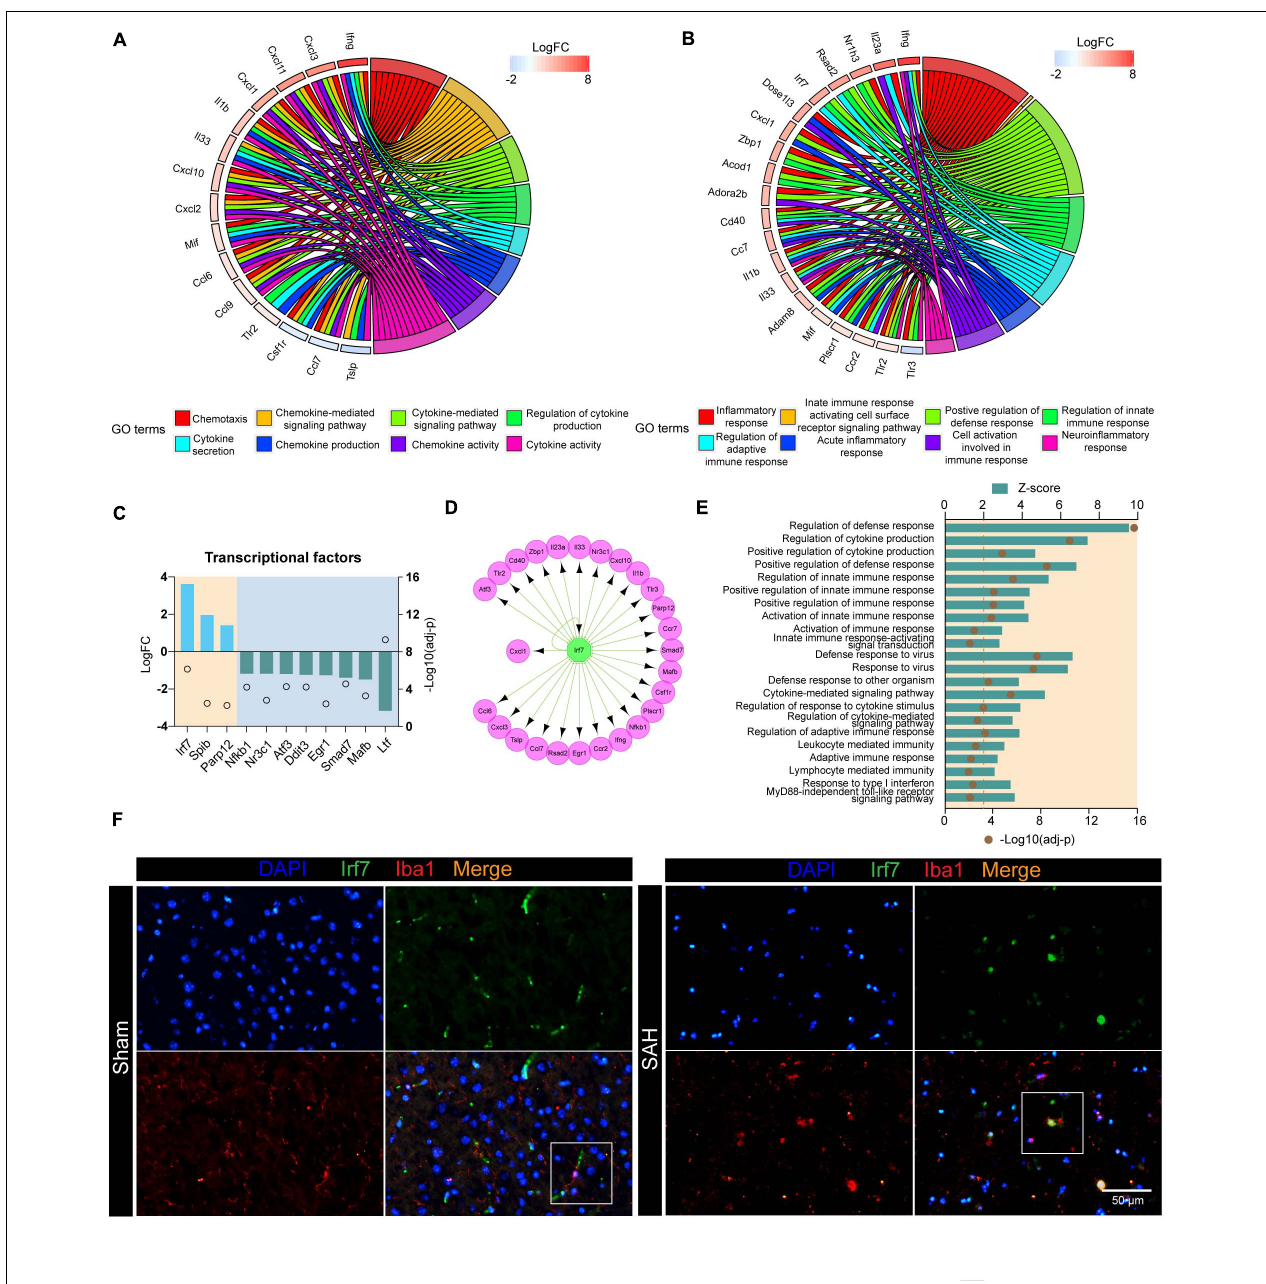
FIGURE 4 | Irf7 is a transcription factor involved in the post-SAH microglia. (A) Circular plot showed the DEGs involved in cytokine- and chemokine-related pathways. (B) Circular plot showed the DEGs involved in inflammatory and immune response-related pathways. (C) Expression profiles of differentially